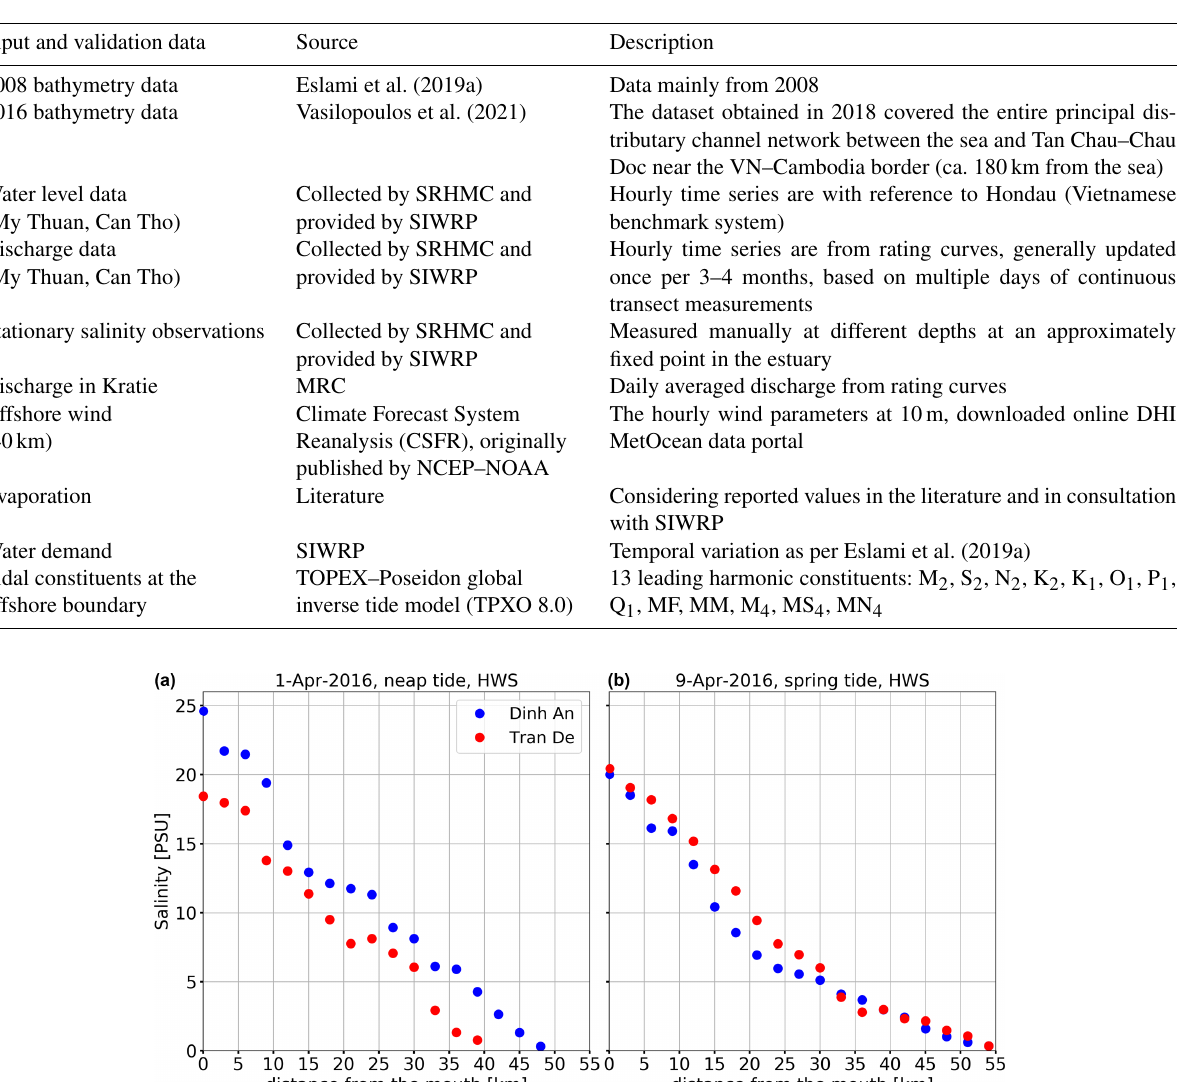
Table 1. Summary of input gauge, bathymetry, wind, and tidal data.